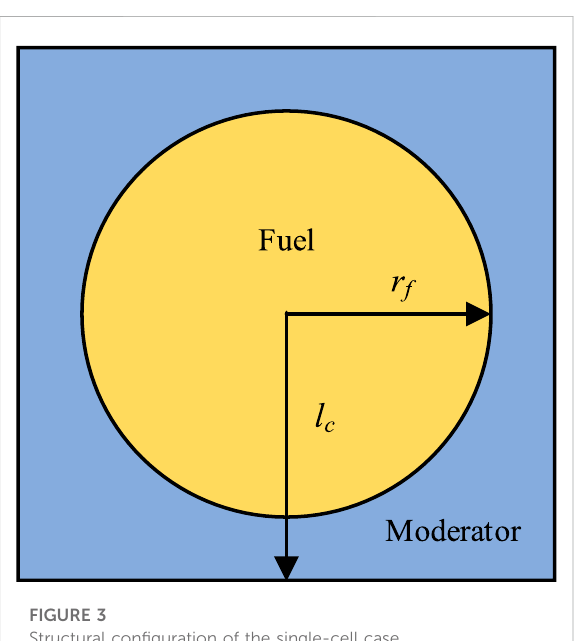
FIGURE 3 Structural con fi guration of the single-cell